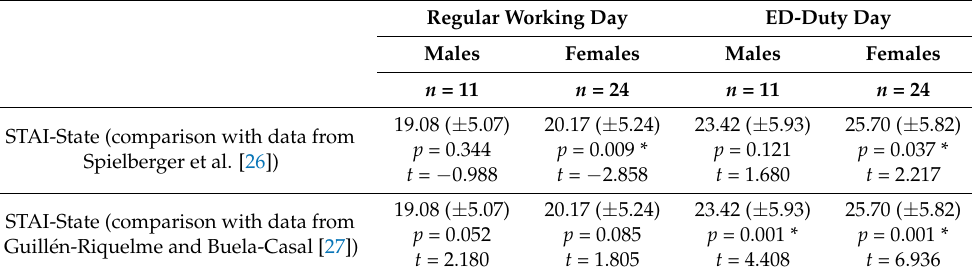
Table 3. State-Trait Anxiety Inventory (STAI)-State anxiety scores on regular working day versus ED-duty day and comparison with population reference values of Spielberger et al. [26] and Guillén-Riquelme and Buela-Casal